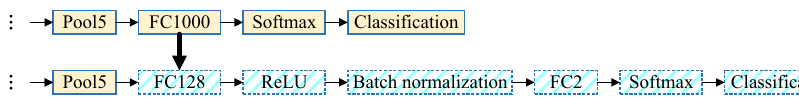
Figure 3. The structure of the residual learning.